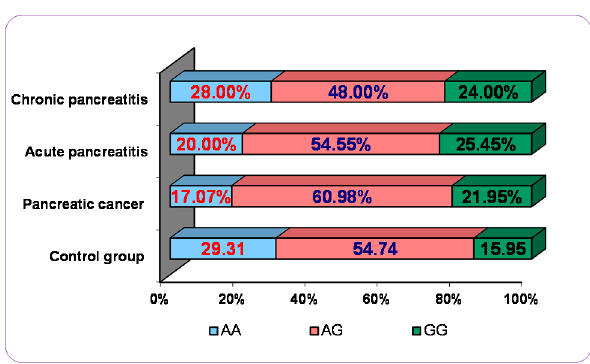
Figure 1. Polymorphism of VEGFR-2 (KDR) 604A>G in different pancreatic disorders vs. control group.